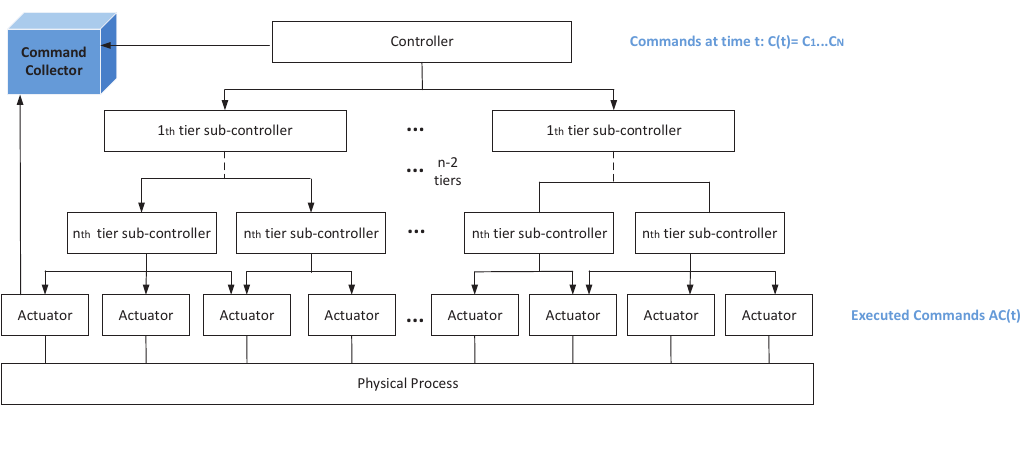
Figure 1. The structure of IIoT control